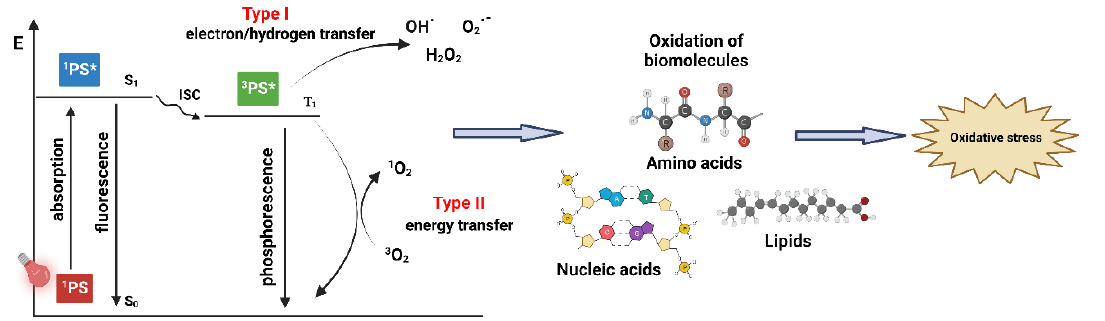
Figure 1. Generation of ROS by two types of processes in PDT leading to oxidative stress. Created with BioRender.com.